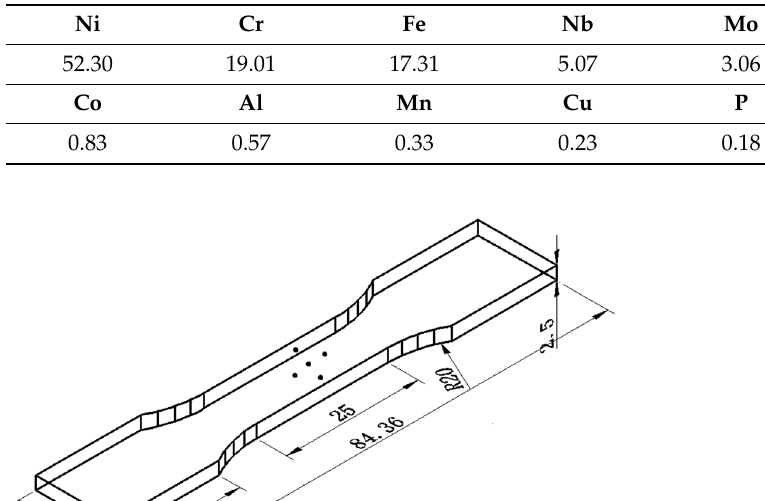
Table 2. Relevant test parameters of residual stress tester. Table 1. Chemical composition of the GH4169 alloy (wt.%).